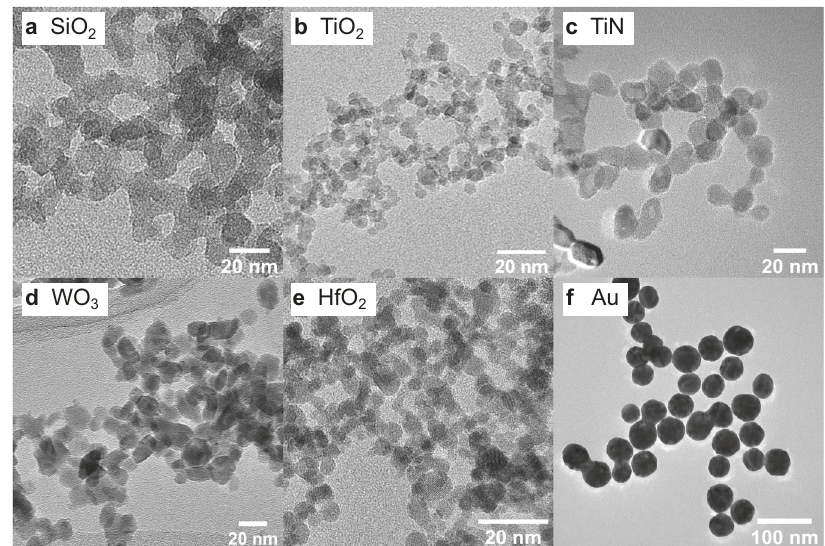
Fig. 1 Nanoparticle morphology. Representative TEM images (overall more than 200 nanoparticles and at least fi ve regions of the sample analyzed for each particle type) of commercially available SiO 2 ( a , A380, Evonik Industries AG, Germany), FSP synthesized metal oxide or nitride nanoparticles ( b – e ) and commercially available 50 nm Au nanoparticles ( f ). Table 1 Physicochemical properties of the nanoparticles used in this study. d Nano- TEM (nm) particle